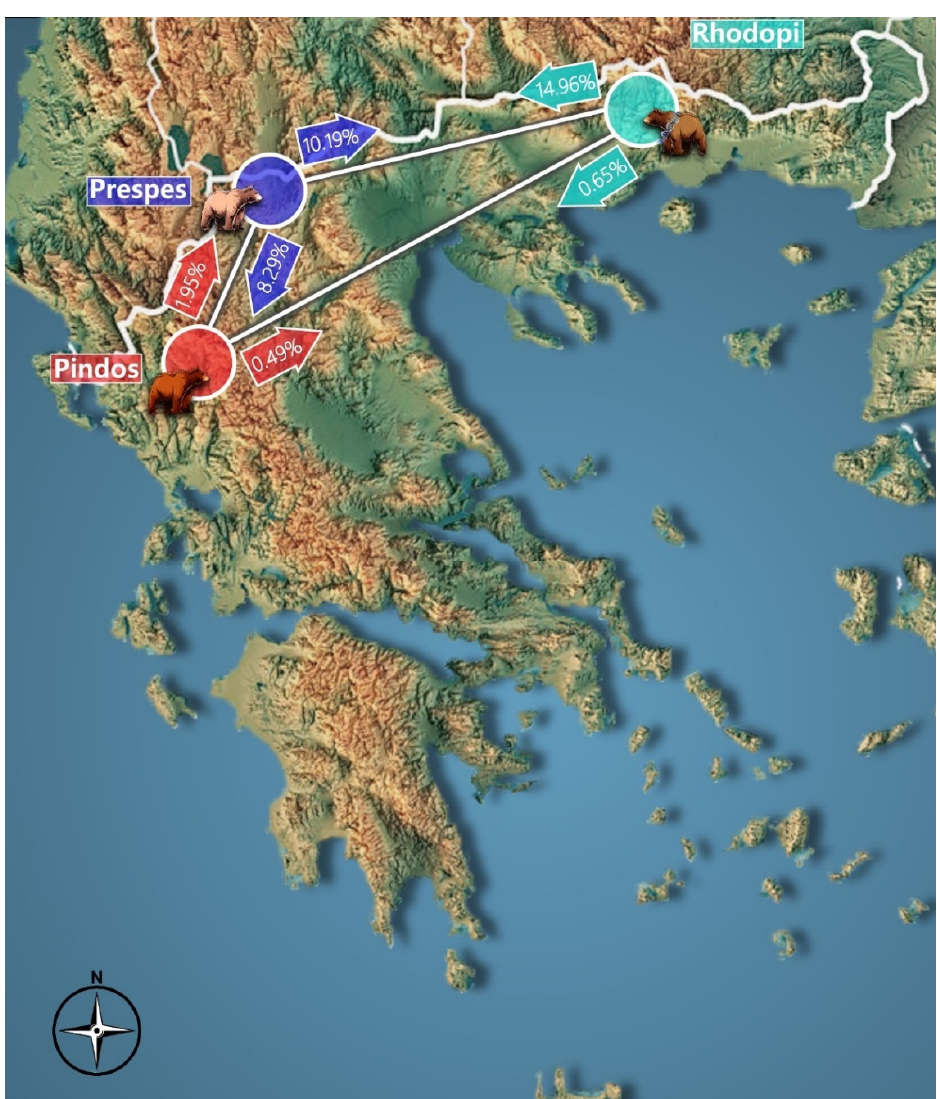
Figure 8. BAYESASS estimates migration rate between populations through gene flow.